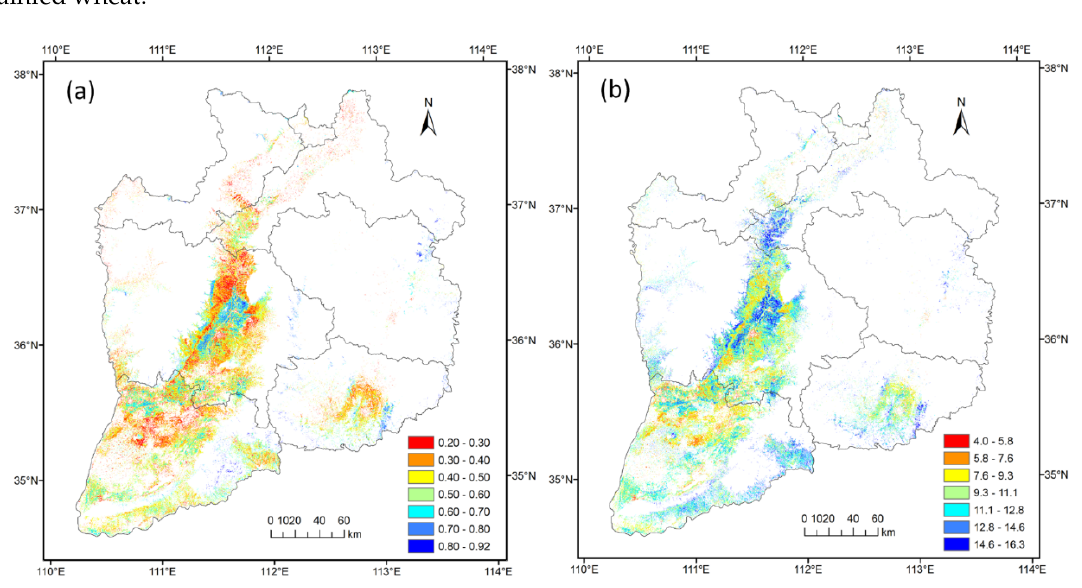
Figure 7. Spatial distribution of maximum NDVI ( a ) and TIN ( b ) of wheat in south central Shanxi Province.